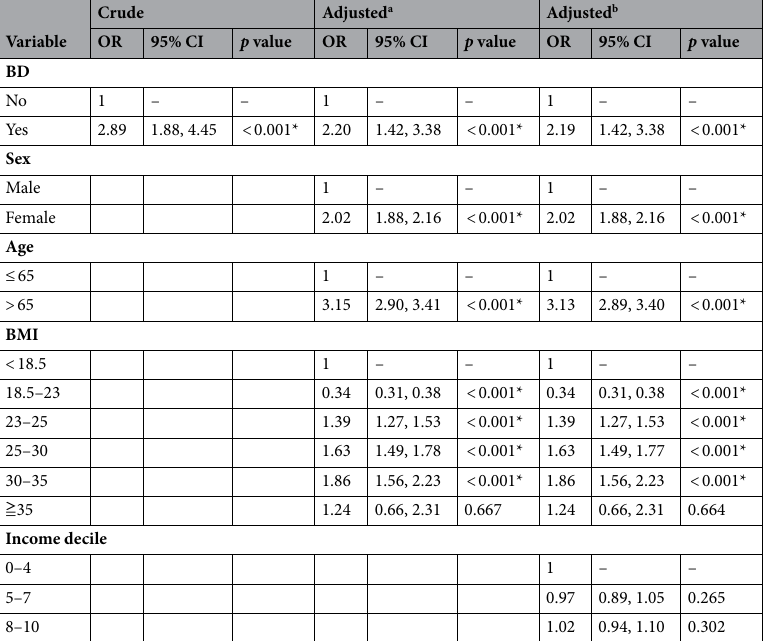
Table 6. Prevalence of psoriatic arthritis by Behçet disease status, with subgroup analyses by sex, age, and income levels. BD, Behçet disease; PsA, psoriatic arthritis; OR, odds ratio (95% confidence intervals); CI, confidence interval. a Adjusted result by sex (male and female) and age (≤ 65 and > 65). b Adjusted result by sex (male and female), age (≤ 65 and > 65) and income (0–4, 5–7 and 8–10). *Statistically significant for p < 0.05.